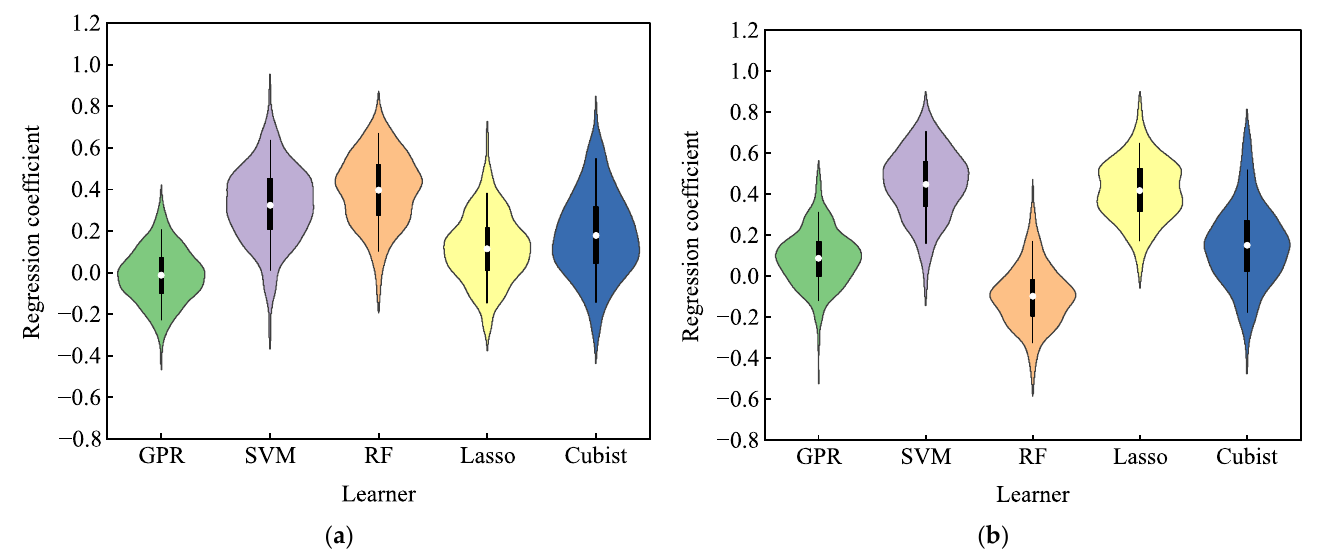
Figure 7. Base model coefficient distribution in secondary models (MLR) in ( a ) 2020 and ( b ) 2021. The best model of LAI achieved from the StMLR method was compared with corre- sponding observed values using scatterplots, as shown in Figure 8. It shows that the esti- mation effect of the model was excellent.